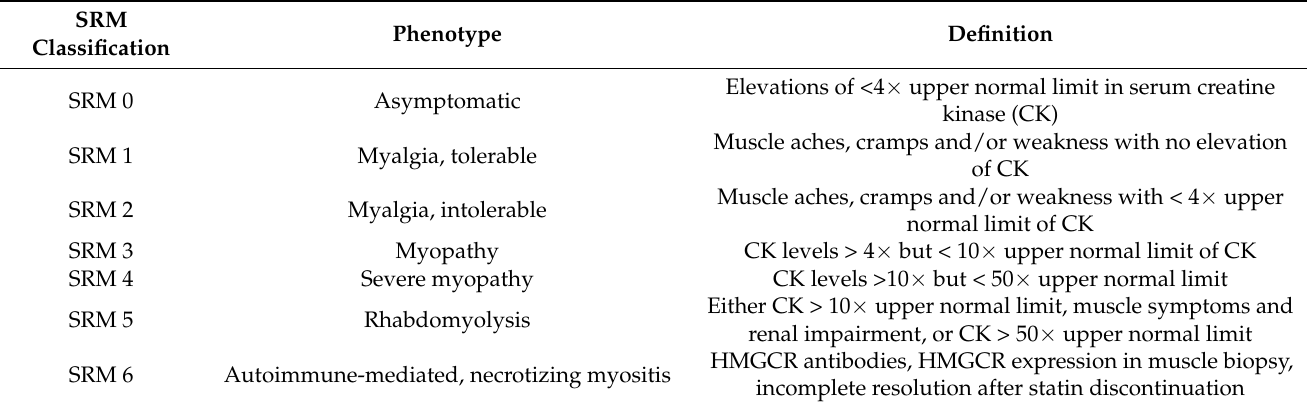
Table 2. Classification of statin-related myotoxic phenotypes (modified from Alfirevic et al.,